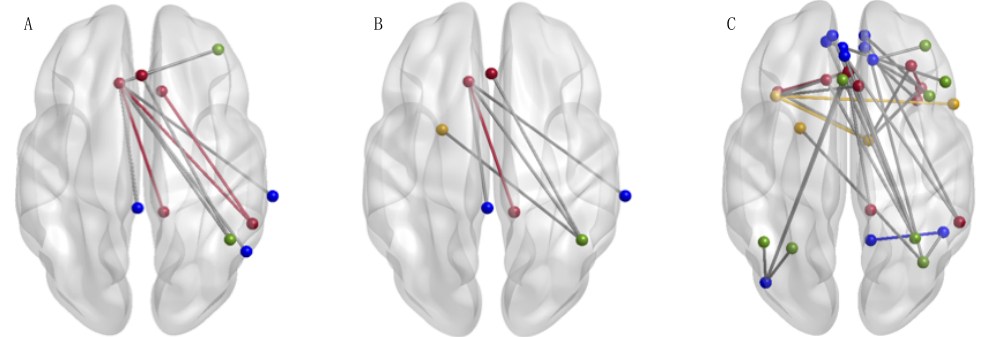
Figure 2. The Network-Based Statistic (NBS) [24] identified resting state functional connectivity effects of Acceptance and Commitment Therapy (ACT) between DMN (blue), FPN (green), SN (red), and the pain network (yellow). This shows decreased functional connectivity (post-ACT > pre-ACT) for ( A ) 10 nodes connected by 10 edges ( t > 2.5; p = 0.05, 10,000 permutations), ( B ) 7 nodes connected by 6 edges ( t > 2.5; p = 0.004, 10,000 permutations), and ( C ) 31 nodes connected by 34 edges ( t > 3.4; p = 0.036, 10,000 permutations). Within network connectivity changes were represented by functional connections of color (a connection within SN nodes (red) will be represented by a red edge, etc.). See Supplementary Materials (Table S3) for details of which nodes of each network were included in these significant networks. Figures were created using BrainNet